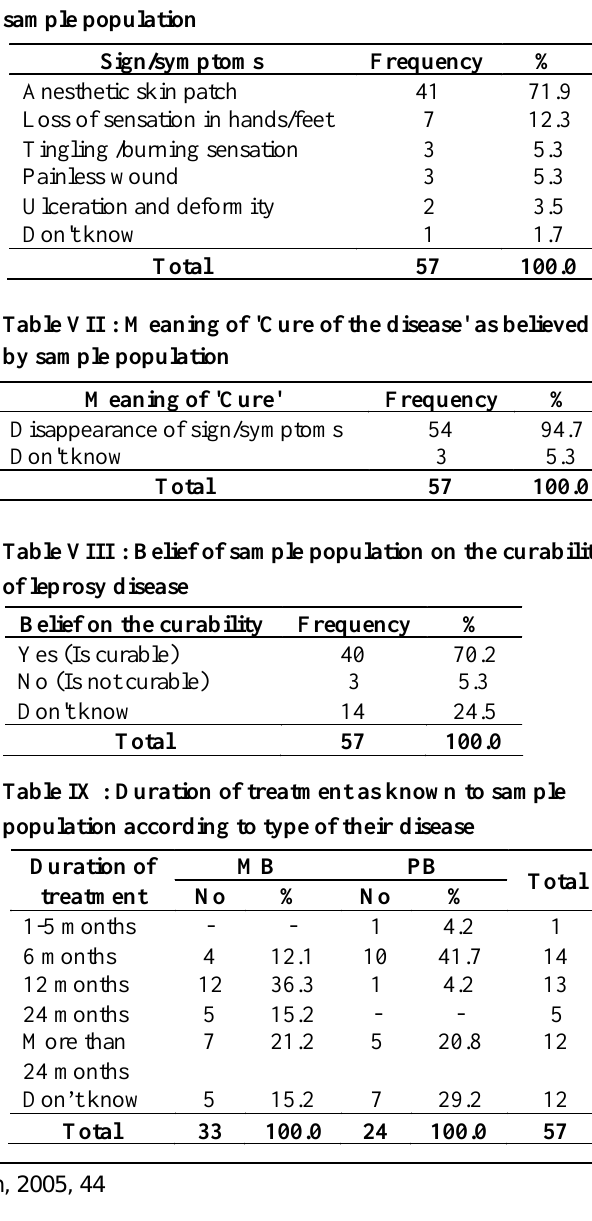
Table VI : Sign/symptoms of leprosy disease as known to